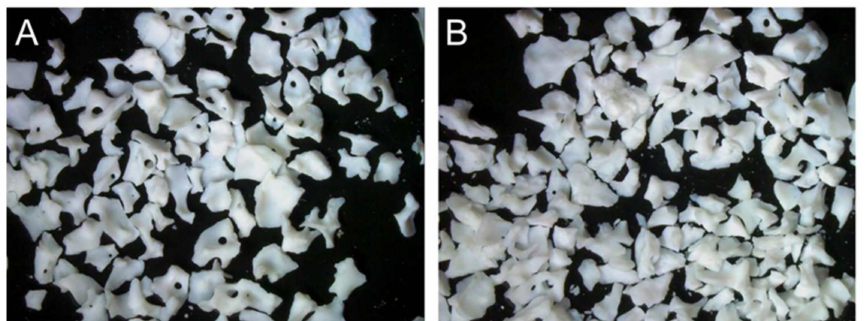
Figure 1. AEB ( A ) and ABB ( B ) particles observed with a stereo microscope.